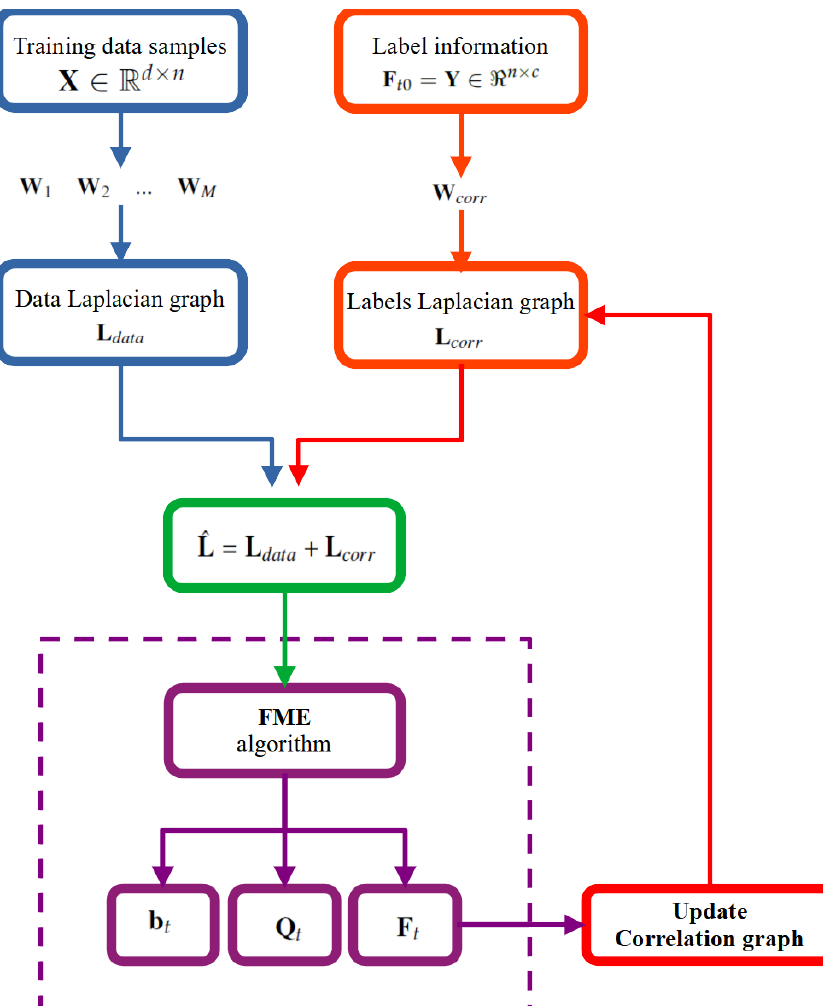
Figure 1. The general flowchart of the multi-view graph fusion that integrates label graph for semi- supervised learning. It is used for multi-class classification problems. Given the training dataset, we construct different similarity graphs based on different descriptors. Then, from the available labelling data, we construct the label space information graph, which we call a correlation graph, and merge both the label space graph and the data space graph into a new graph that is used in the FME algorithm to predict the beauty value of the unknown face